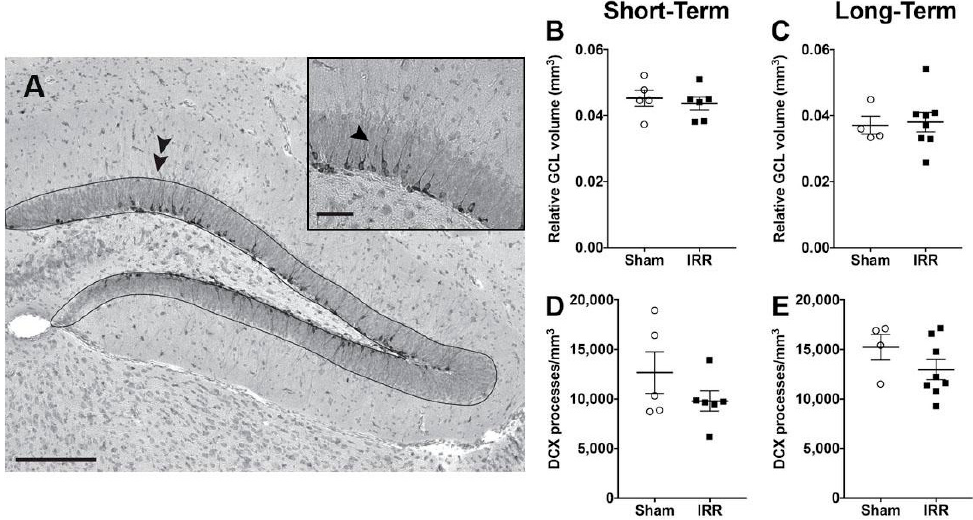
Figure 9. 24-h and 3-mon post- 12 C irradiation, relative GCL volume, and the dendritic density of DCX+ cells were similar between Sham and IRR mice. ( A ) Main image: Representative photomicrograph of DCX staining depicting GCL boundary (dotted line, indicated by double arrowheads). When used in combination with the optical fractionator and Cavalieri’s principle, this approach reveals the relative GCL volume quantified in B and C. Inset: Higher magnification of the dendritic processes of DCX+ cells (arrowhead). The density of DCX+ dendritic processes perpendicular to the GCL is presented in D and E. Scale bar = 100 µm main image; 50 µm inset. ( B , C ) Relative GCL volume in Sham and IRR mice 24-h (Short-Term, B; N = 5 Sham, N = 6 IRR) and 3-mon (Long-Term, C; N = 4 Sham, N = 8 IRR) post-irradiation ( p ’s > 0.05). ( D , E ) Density of DCX+ dendritic processes perpendicular to the GCL in Sham and IRR mice 24-h (Short-Term, D; N = 5 Sham, N = 6 IRR) and 3-mon (Long-Term, E; N = 4 Sham, N = 8 IRR) post-irradiation ( p ’s > 0.05).